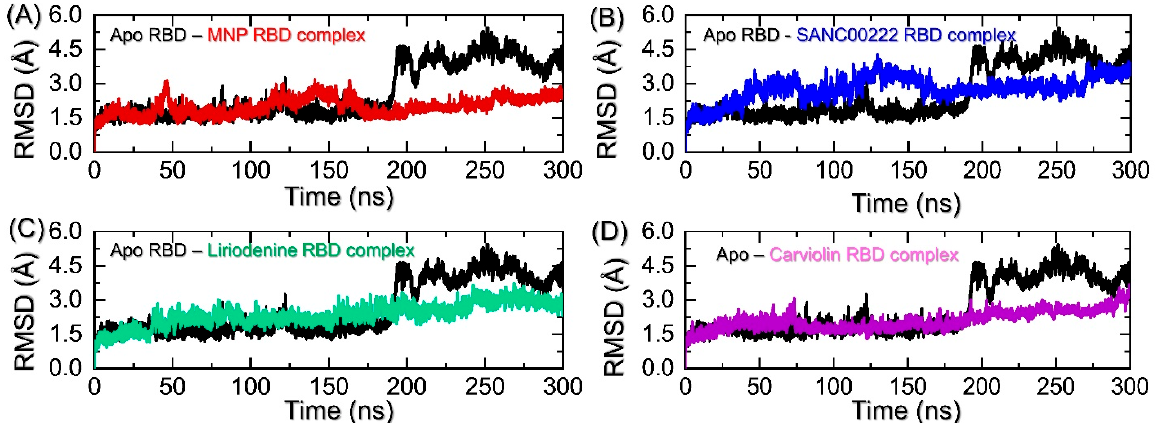
Figure 5. Determination of structural stability in a dynamic environment for the apo-RBD and top complexes. ( A ) shows the RMS d patterns for apo-RBD and MNP-RBD complex, ( B ) shows the RMS d patterns for apo-RBD and SANC00222-RBD complex, ( C ) shows the RMS d graphs for apo-RBD and Liriodenine-RBD complex, while ( D ) represents the RMS d graphs for apo-RBD and Carviolin-RBD complex over the course of the 300 ns simulation time.